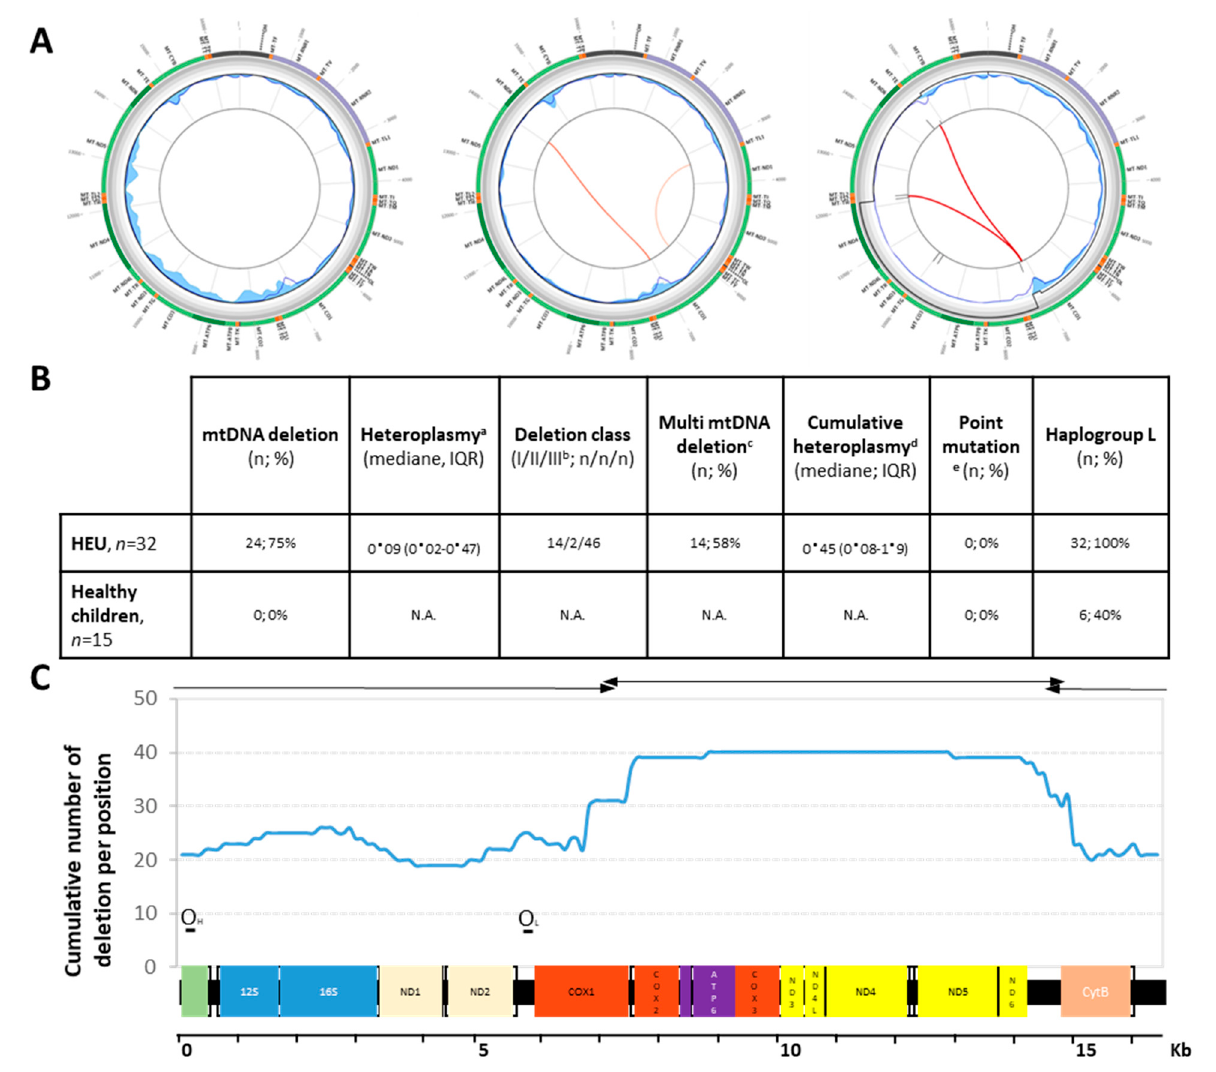
Figure 1. mtDNA deletions among HEU children. ( A ) Schematic representation of the eKLIPse high-throughput computational pipeline result. The outer circle represents the mtDNA genome. Deletions are visualized in the center of the circles as red lines. Left: a subject with no deletion, middle: a subject with two deletions of different heteroplasmy, right: a subject with two deletions of high heteroplasmy. The width of the red line varies according to the percentage of heteroplasmy. The inner circle contains data related to the sequencing coverage and quality control of the sequencing (see [30] for details). ( B ) The data for each child population. a: heteroplasmy corresponds to the percentage of deleted to wild-type mtDNA molecules; b: class I deletions are flanked by perfect repeats, class II deletions are flanked by imperfect repeats, and class III deletions are not flanked by any similar sequences; c: multiple mtDNA deletions are defined as having more than one type of deletion, d: cumulative heteroplasmy is defined as the sum of each heteroplasmy for one individual; e: point mutation is defined as any heteroplasmic pathogenic variant. IQR: first and third interquartile range; HEU: HIV-exposed uninfected children. ( C ) Deletion profile among HEU children. The cumulative number of deletions per position was plotted against a linear mitochondrial genome. Products of long-range PCR amplification are depicted on top of the diagram. The two origins of replication (OH and OL) are